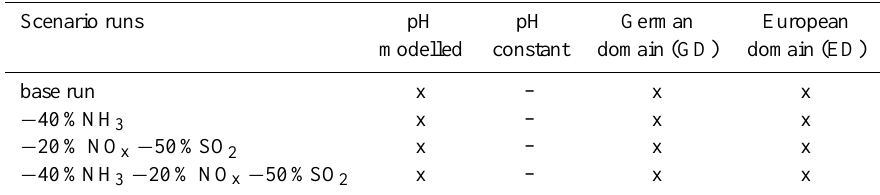
Fig. 1. Spatial distribution of the total annual (a) SO x , (b) NO x and (c) NH 3 emissions in ta − 1 cell − 1 . Table 1. Overview of performed emission reduction scenario runs and their